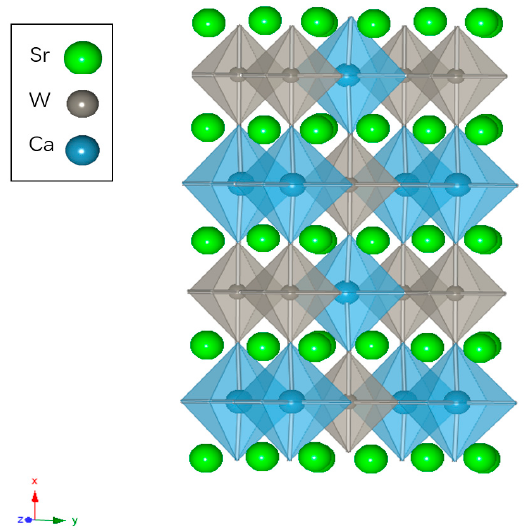
Figure 2. The crystal structure of Sr 2 CaWO 6 in which Sr atoms are marked with green ball, gray WO 6 octahedrons and cerulean CaO 6 octahedron are shown to represent coordination of W atoms and Ca